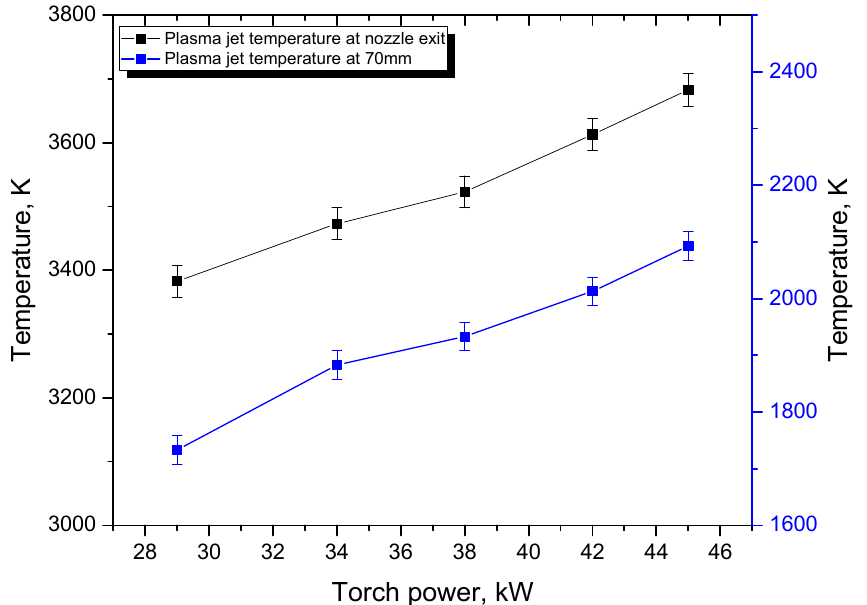
Figure 1. Plasma jet temperature at the nozzle exit and at a distance of 70 mm as a function of input power. A similar tendency can be observed with the plasma jet velocity (Figure 2). The velocity of the plasma jet gradually increases along the axial direction from 965 m/s at Table 1. Summary of plasma jet operational settings. 29.4 kW to 1060 m/s at 45.1 kW input power. This could be explained by the fact that the velocity of the plasma jet is strongly temperature-dependent, and it increases with an increasing arc current [28,29].